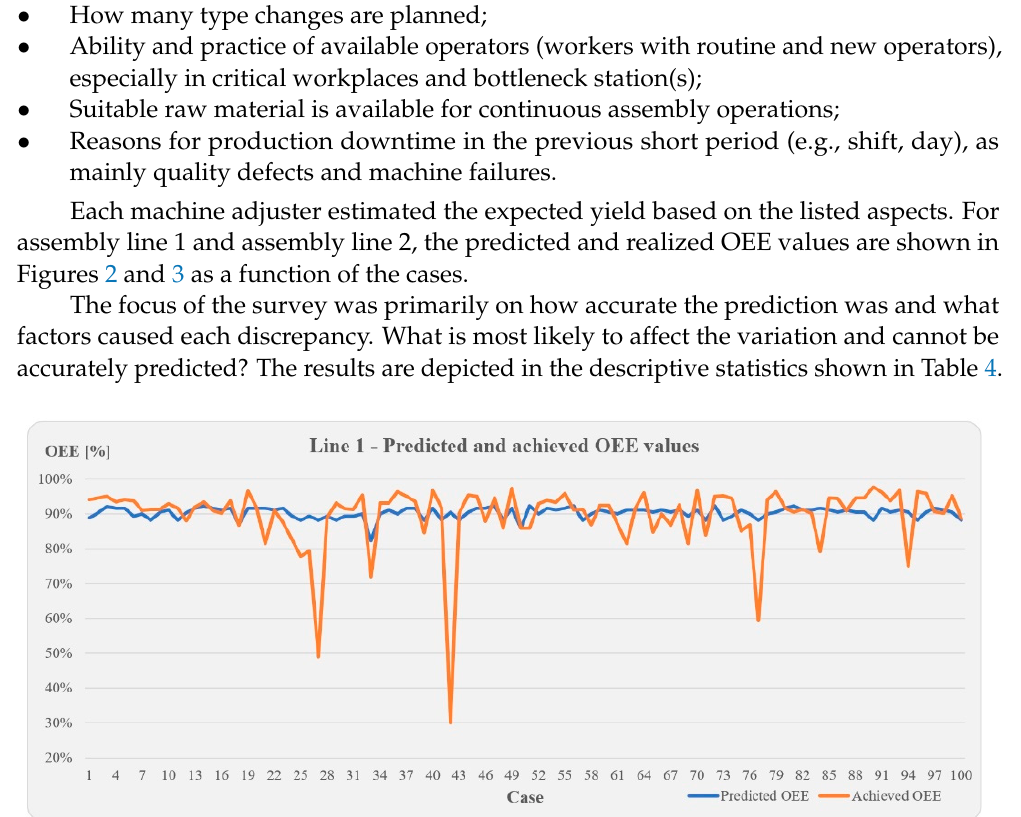
Figure 3. Predicted and achieved OEE values for assembly line 2. The focus of the survey was primarily on how accurate the prediction was and what factors caused each discrepancy. What is most likely to affect the variation and cannot be accurately predicted? The results are depicted in the descriptive statistics shown in Table 4. Table 4. Descriptive statistics OEE values for assembly line 1 and assembly line 2. Assembly Line 1